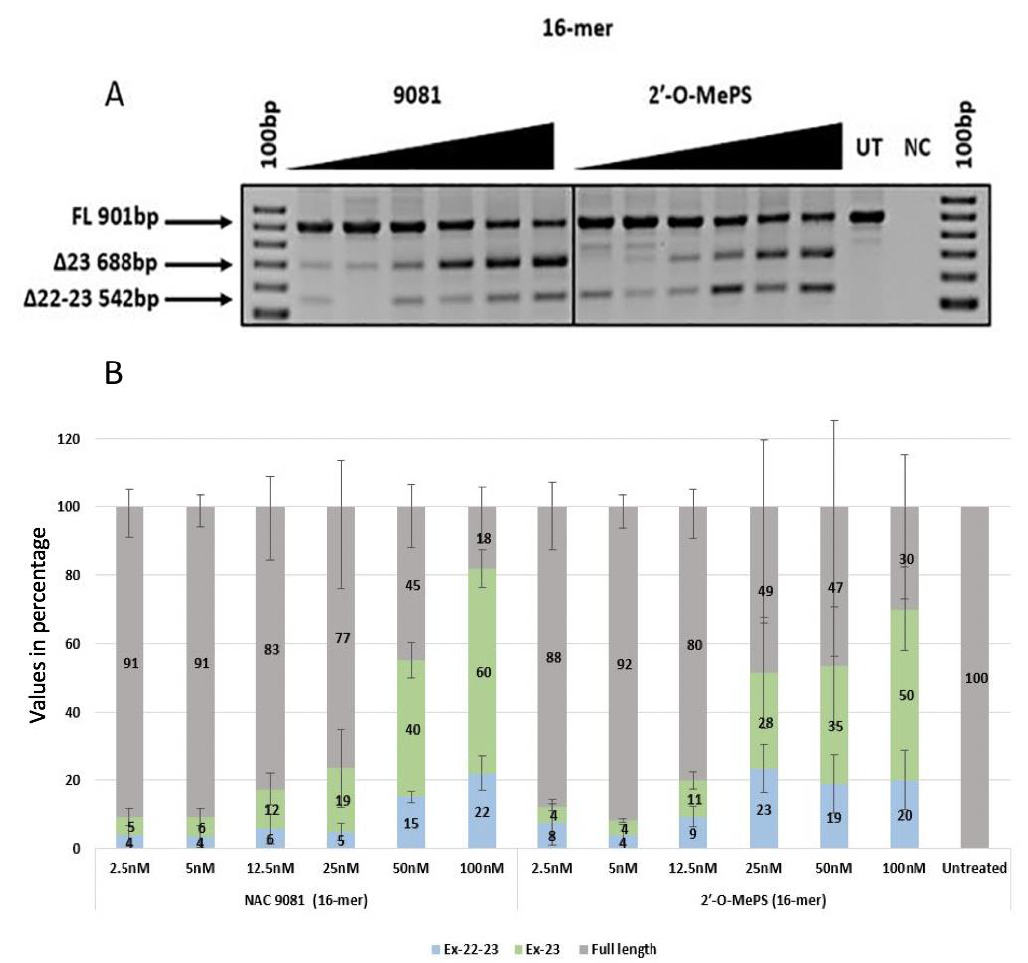
Figure 5. ( A ) RT-PCR analysis of exon-23 skipping induced by AO NAC 9080 and the corresponding 2′ -OMePS control AO in H2K mdx mouse myotubes (gel image A corresponds to one of the three gels used for data in ( B ); ( B ) densitometry analysis of exon-23 skipping induced by AO NAC 9080 and the corresponding 2′ -OMePS control AO (triplicates) in H2K mdx mouse myotubes. Concentration range 2.5 – 100 nM. Grey, full-length product exon 20 – 26; green, exon-23 skipped product; blue, dual exon 22/23 skipped product; UT, untreated; NC, negative control (Error bars represent the standard deviation of mean).